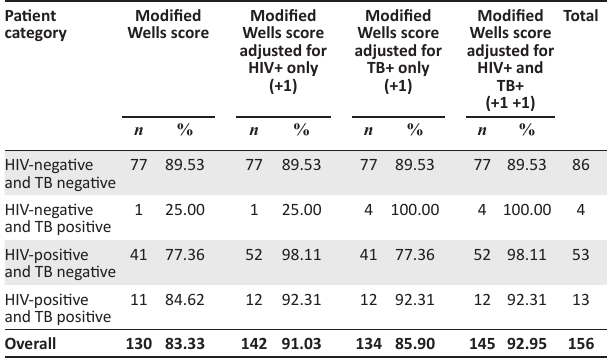
TABLE 4 : Sensitivity of the modified Wells score, before and after adjustment for HIV and/or tuberculosis. Patient